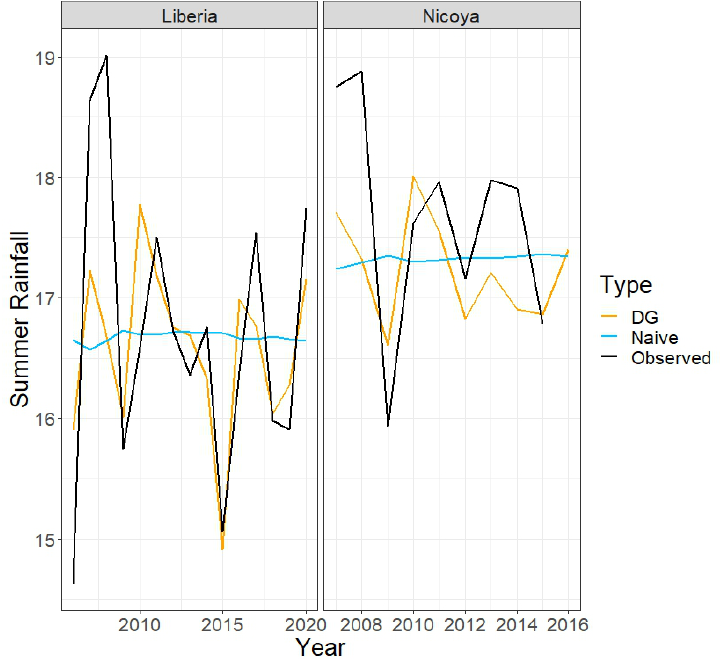
Figure 4. Predicted (using the double Gaussian and naive approaches) and observed total summer rainfall values at the Liberia station ( left ) from 2006 to 2020 and at the Nicoya station ( right ) from 2007 to 2016. Rainfall is reported on the scale log ( Y it ) +